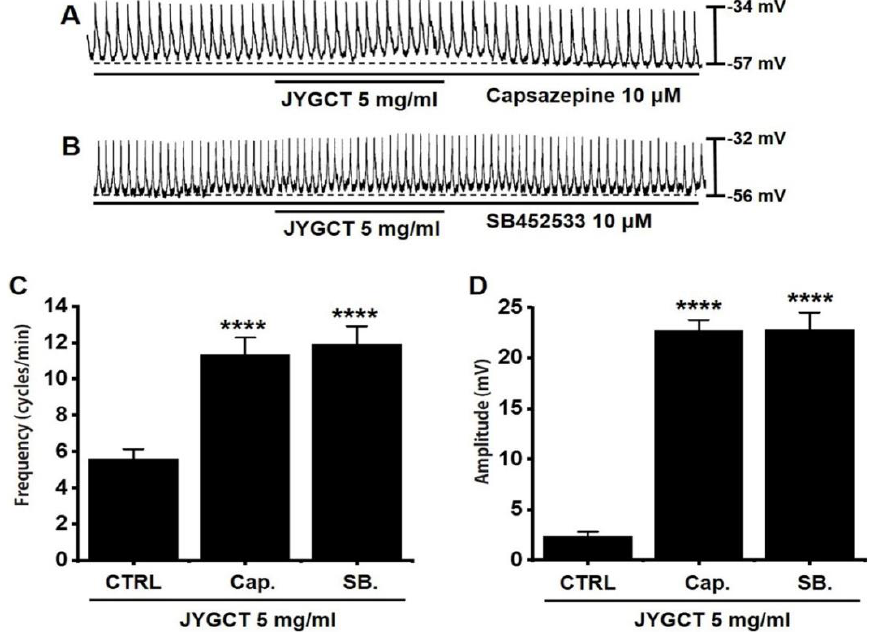
Figure 3. Effect of capsazepine or SB452533 on the pacemaker potential inhibition by JYGCT in the ICC. ( A ) Pretreatment with capsazepine blocked the pacemaker potential inhibition by JYGCT; ( B ) SB452533 blocked the pacemaker potential inhibition by JYGCT; ( C , D ) Summary of the inhibitory frequency and amplitude effects of pretreatment with capsazepine or SB452533. Bars represents the mean ± SE. **** p < 0.0001. JYGCT: Jakyakgamcho−tang; Cap: capsazepine; SB: SB452533; CTRL: control.